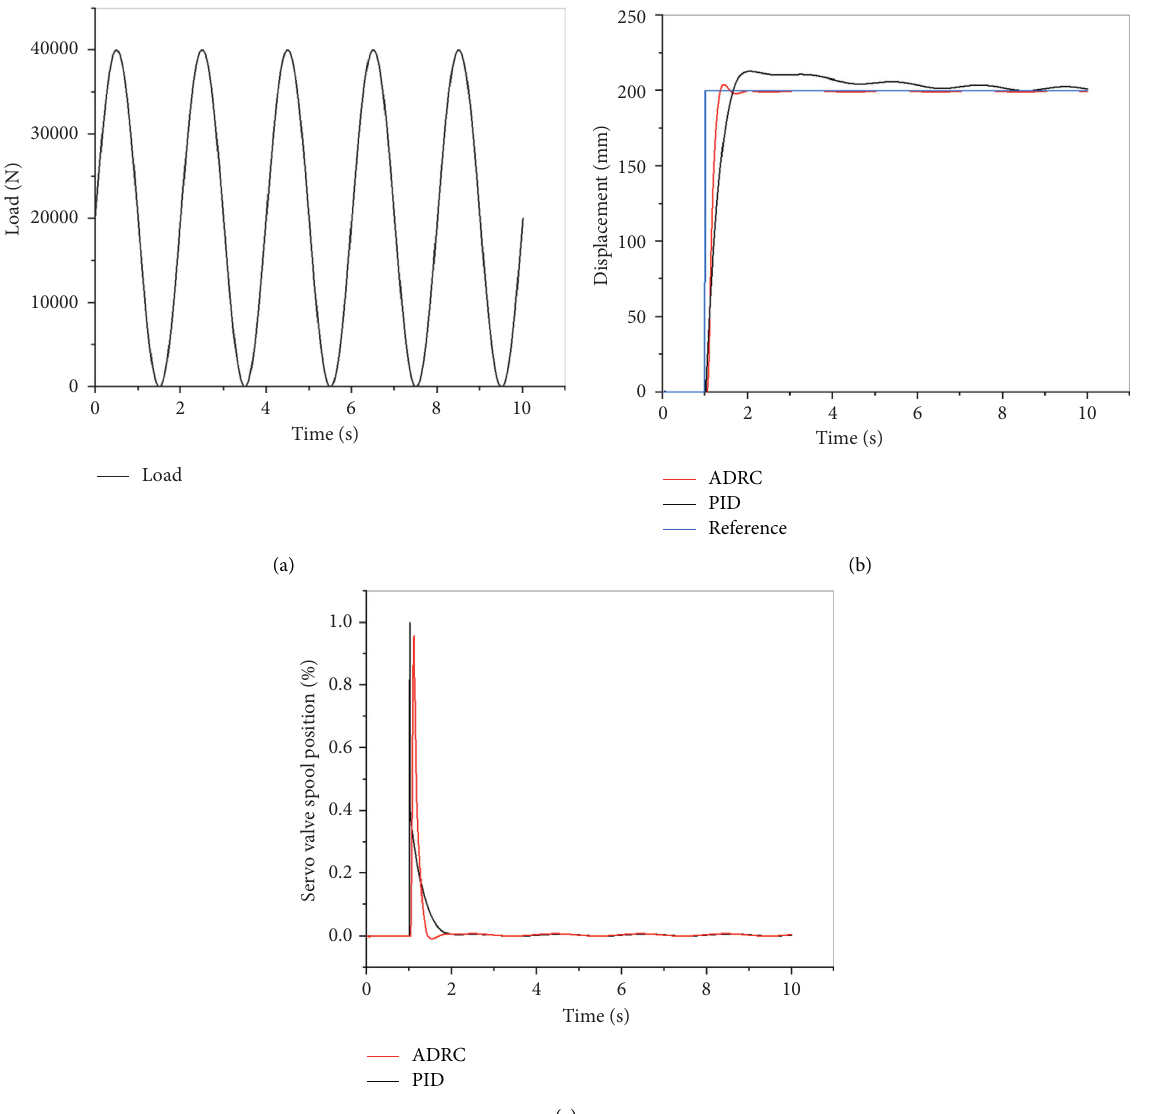
Figure 8: Step responses in ADRC and PID under variable load. (a) Sinusoidal load. (b) Cylinder displacement response. (c) Spool position